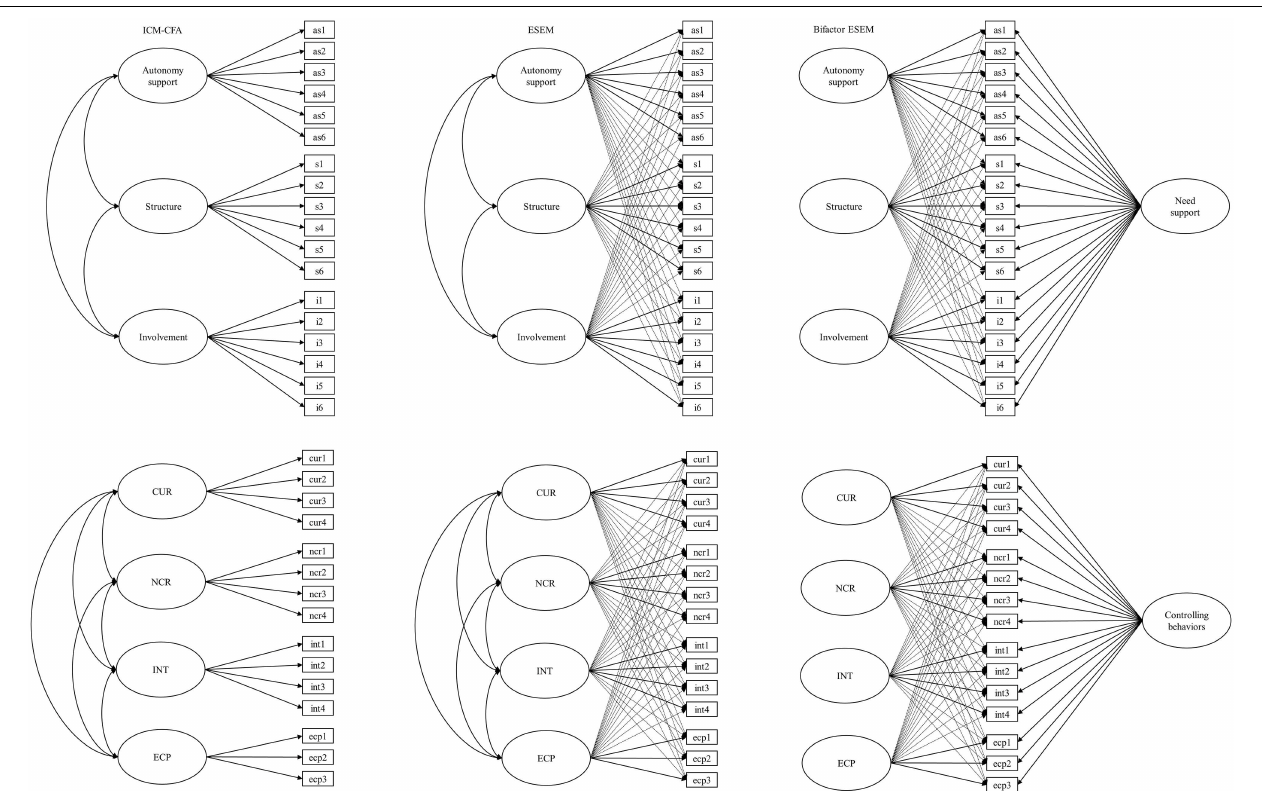
FIGURE 1 | Graphical representation of the alternative models tested in these two studies. The top three are the ICM-CFA, first-order ESEM, and bifactor ESEM of the ISS-C. Bottom three are the ICM-CFA, first-order ESEM, and bifactor ESEM of the CCBS. Dotted lines represent non-target loadings. CUR, controlling use of rewards; NCR, negative conditional regard; INT, intimidation; and ECP, excessive personal control.